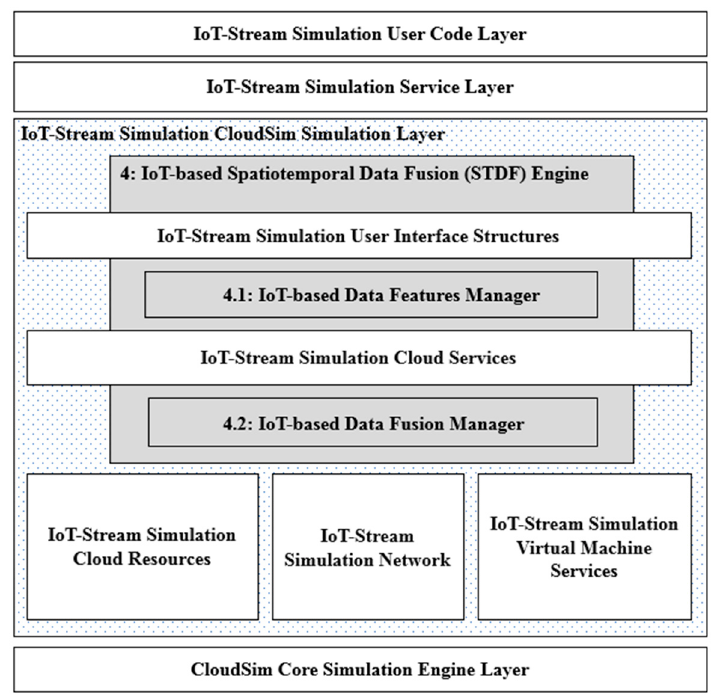
Figure 6. The proposed architecture of the spatiotemporal data fusion (STDF) engine on top of the IoTSim-Stream simulator.